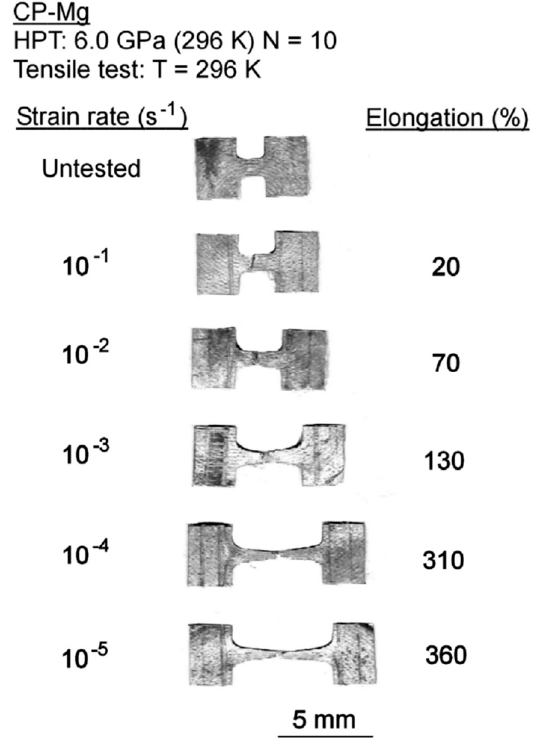
Figure 7. Appearance of specimens of pure magnesium processed via HPT and pulled to failure at room temperature [25].